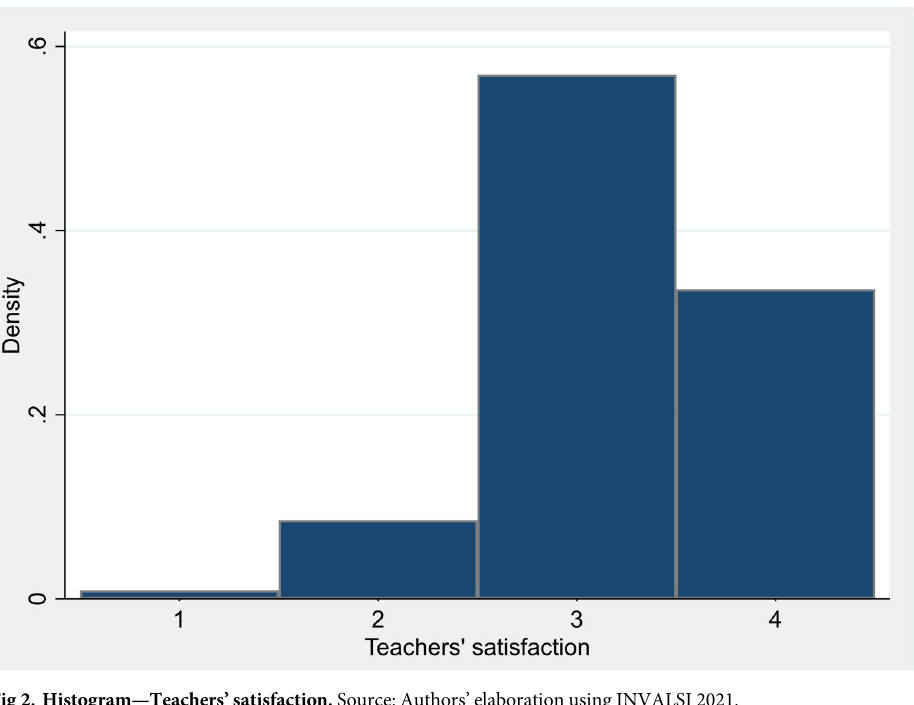
Fig 2. Histogram—Teachers’ satisfaction. Source: Authors’ elaboration using INVALSI 2021.